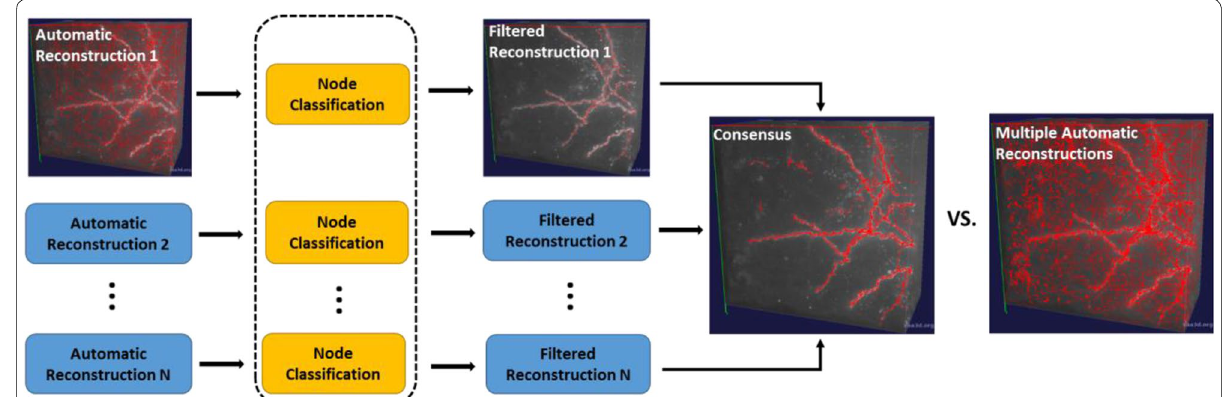
Fig. 6 The workflow of consensus generation using the smart pruning module. Multiple automatic reconstructions are filtered by CNN‑based classification models first. Then, all filtered reconstructions are fused together to produce a consensus. Reconstructions are shown in red lines on top of the original image stack